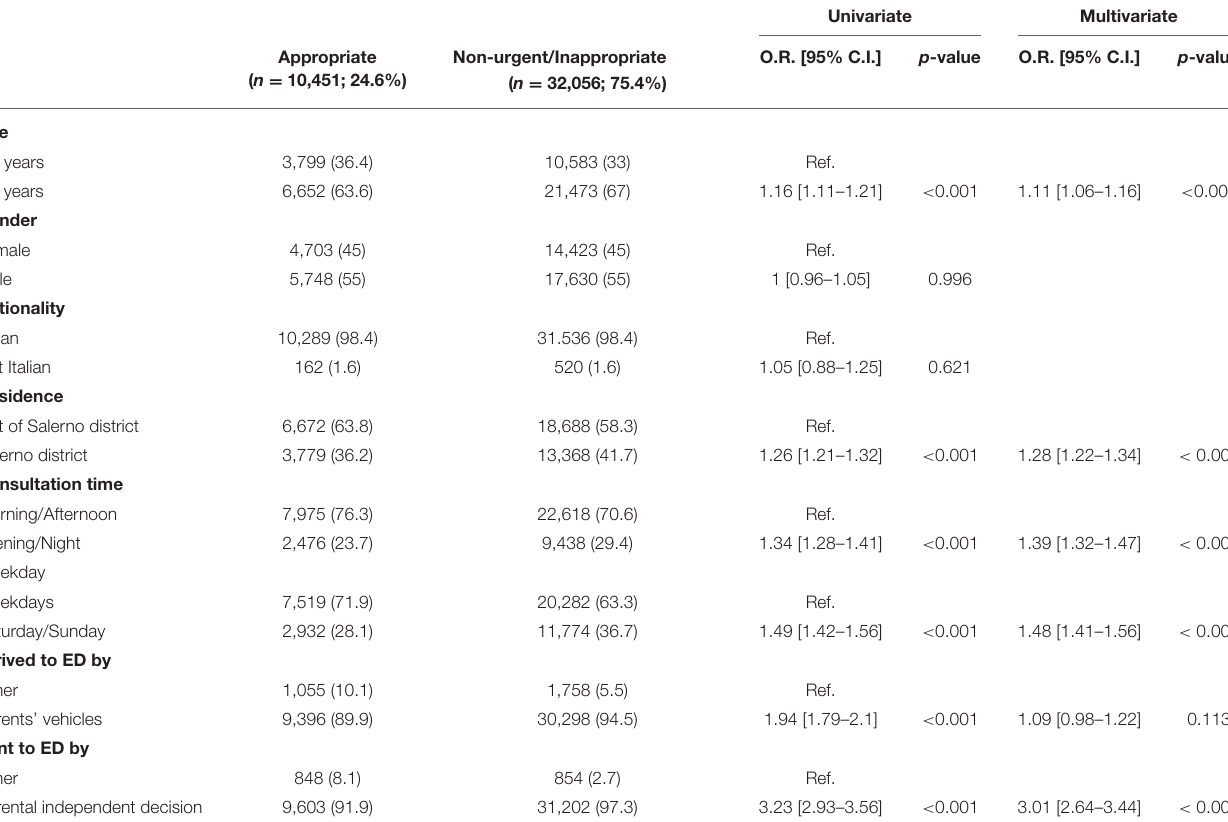
TABLE 4 | Univariate and multivariate analyses of predictors of non-urgent/inappropriate visits*.